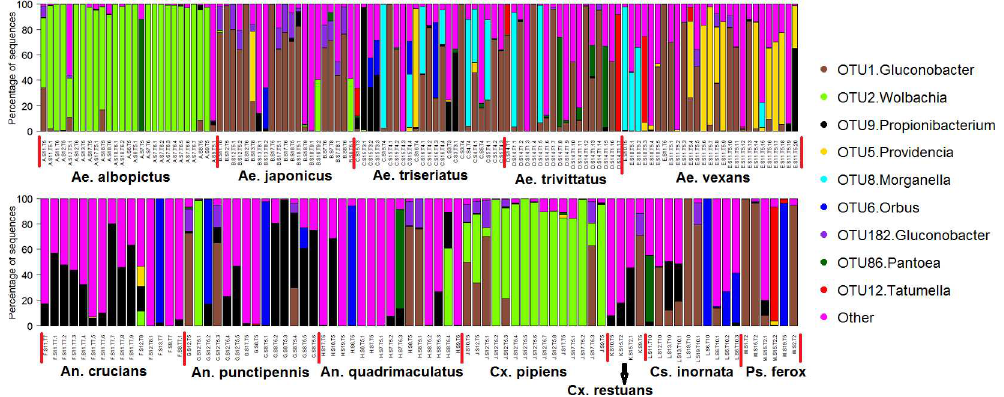
Fig 2. Mean relativeabundances of bacterialOTUs associated with 12 speciesof mosquitoes at different sites and collection dates. OTUs with abundance of less than1.5% werepooledtogetheras “Other”. S = trap site, S1 = 504 S LynnSt, ChampaignIL; S2 = 1509GrandviewDr, Champaign IL; S3 = 408 W MapleSt, ChampaignIL; S4 = 1809GrandviewDr, ChampaignIL; S5 = 805 S. PrairieSt, ChampaignIL; S6 = 1116CharlesSt, ChampaignIL; S7 = 604 W HillSt, ChampaignIL; S8 = 1605Coronado Dr, Champaign IL; S9 = 1413S Western Ave, Champaign IL; S10 = 909 S McKinley, ChampaignIL; S11 = 1418S Western Ave, ChampaignIL; S12 = 409 W Hill St, Champaign IL; S13 = 705 W Kirby Ave, ChampaignIL; S14 = 602 NevadaSt, UrbanaIL; S15 = 602 Vermont Ave, UrbanaIL; S16 = 2402E Elm St, UrbanaIL; S17 = 804 W MainSt, UrbanaIL; S18 = 807 W MainSt, UrbanaIL; S 19 = 2010 Morrow Ct, UrbanaIL. T = dateof collection; T1 = July, 2, 2015; T2 = July, 7, 2015;T3 = July, 21, 2015;T4 = July, 28, 2015; T5 = August, 3, 2015;T6 = August, 11, 2015;T7 = August, 19, 2015;T8 = August,28, 2015; T9 =